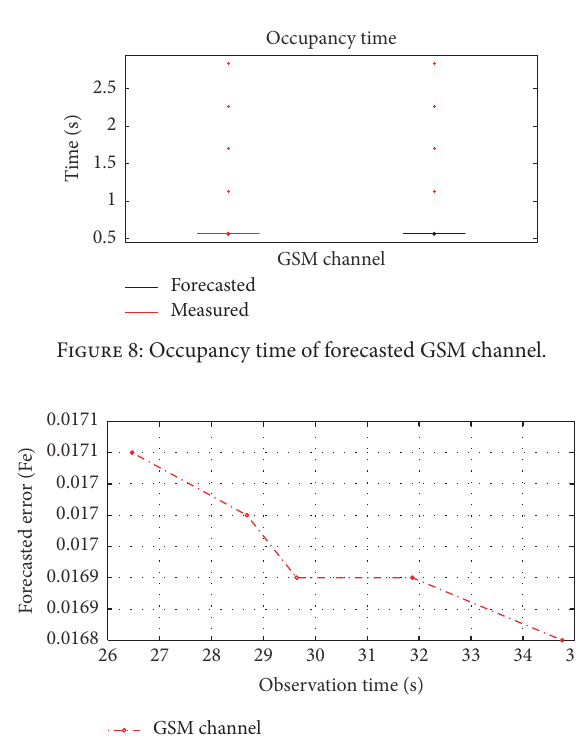
Figure 9: Forecast error versus observation time for the GSM channel.